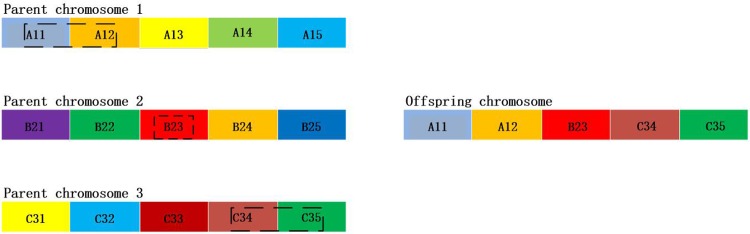
Three-exchange heuristic crossover operator method with 5 genes.